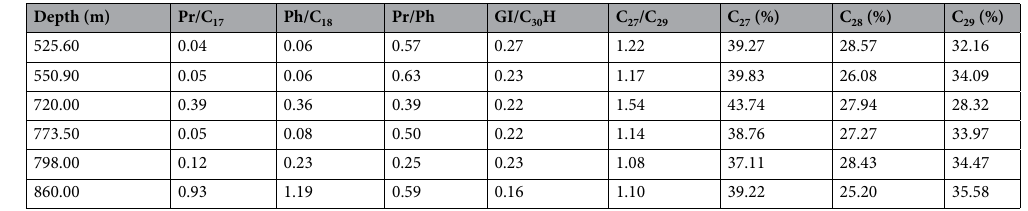
Table 2. n-Alkane and isoprenoids biomarker ratios calculated from TIC, m/z = 191, m/z = 217 mass fragmentogram of selected Xihuapidianzi Formation extracts. Pr pristine, Ph phystane, GI/C 30 H gammacerane